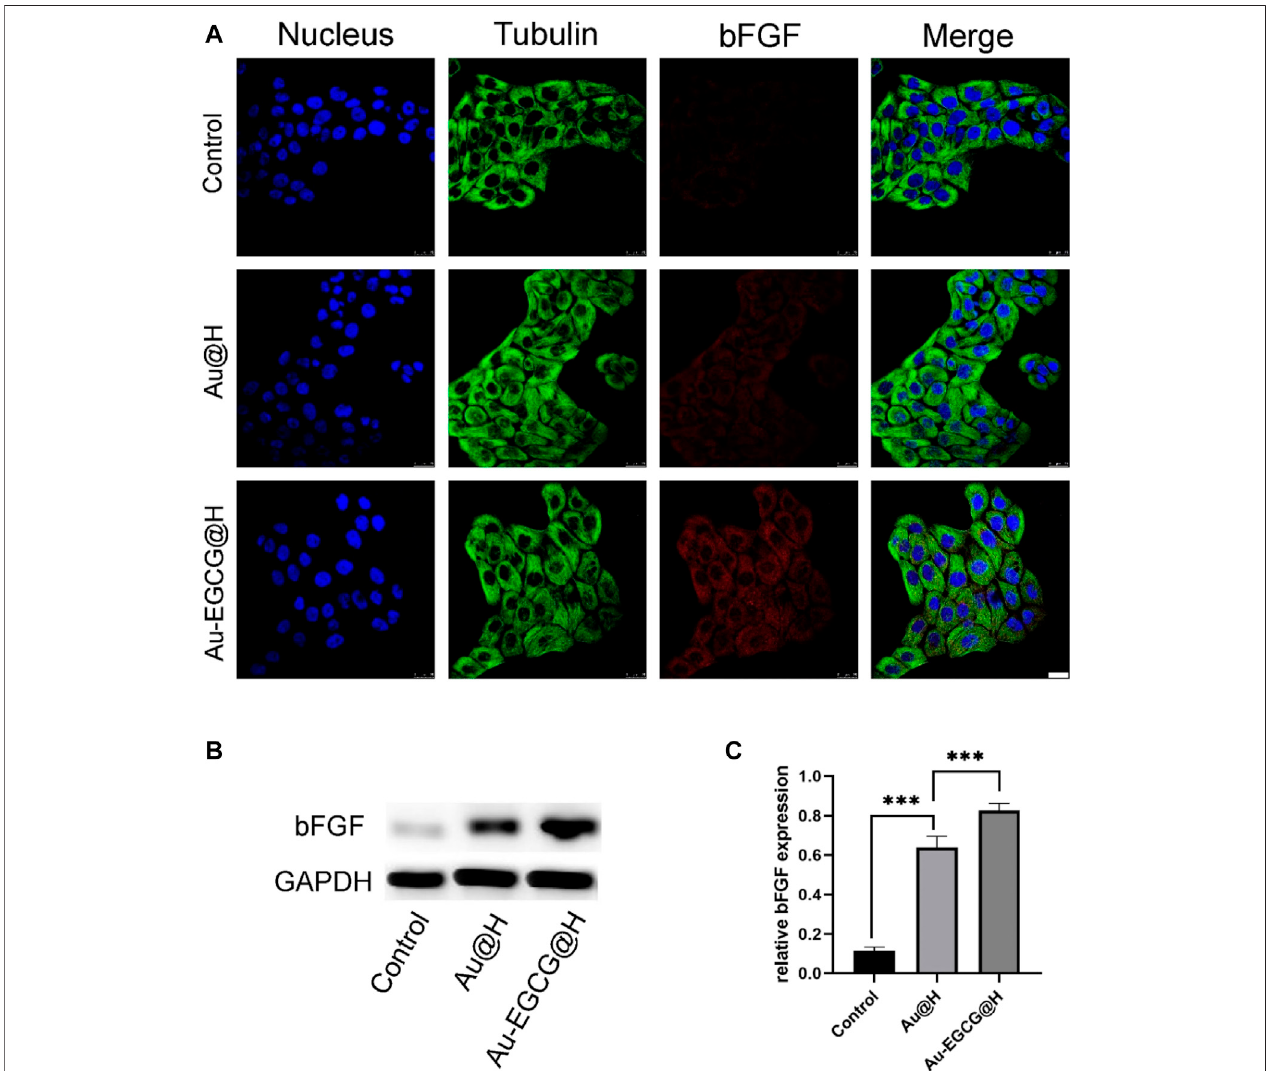
FIGURE 5 | The expression analysis of basic fi broblast growth factor (bFGF) under different treatments. (A) The images of confocal laser scanning microscopy (CLSM) for the bFGF expression analysis, bar (cid:2) 25 μ m. (B) The expression level of bFGF protein was analyzed by western blot. (C) Quanti fi cation analysis of the bFGF protein. * p < 0.05, ** p < 0.01, *** p <